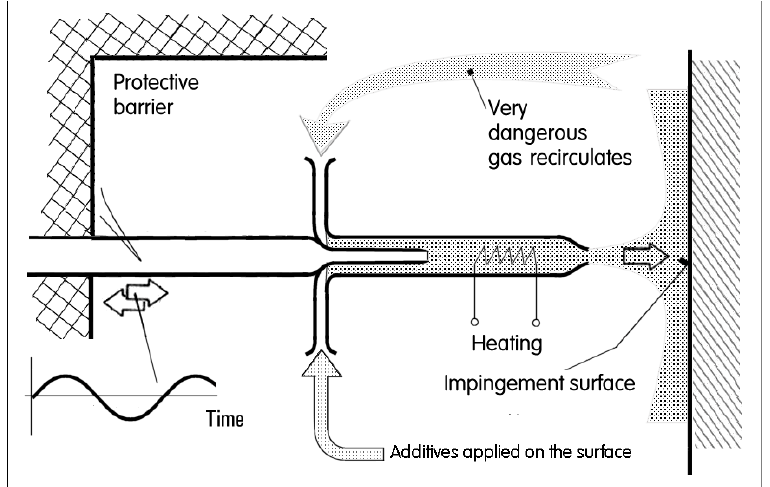
Figure 17. Characteristics of the rectification effect at the other end of the reactor output loading.